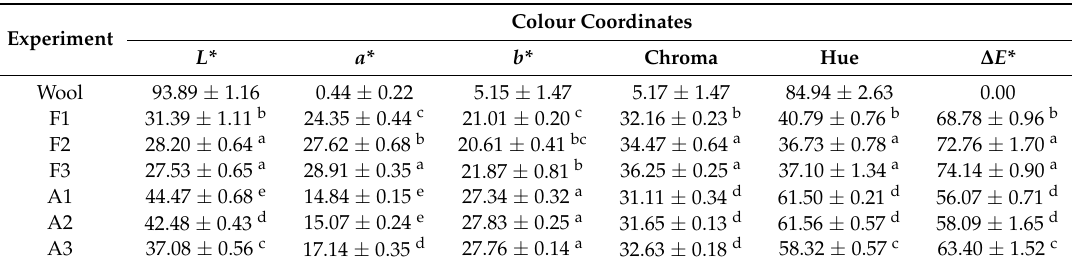
Table 2. L* , a* , b* values of dyed wool.